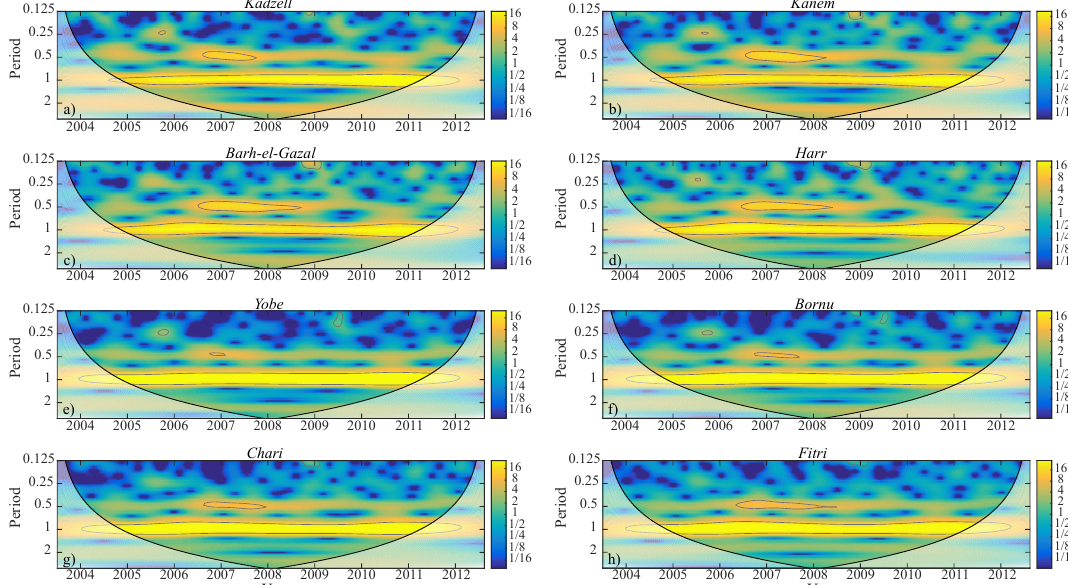
Figure 3. Continuous wavelet power spectrum (CWT) of the GRACE signal for each tile (see locations in Figure 1). The x -axis represents the time. The y -axis is the time converted to its equivalent Fourier period. It represents 2 years; 1 year; and 6, 3, and 1 1 months. The color scale represents the spectral 2 power. The COI (i.e., region affected by edge effects) is represented as a lighter zone. Grey thin contours highlight the 95% confidence